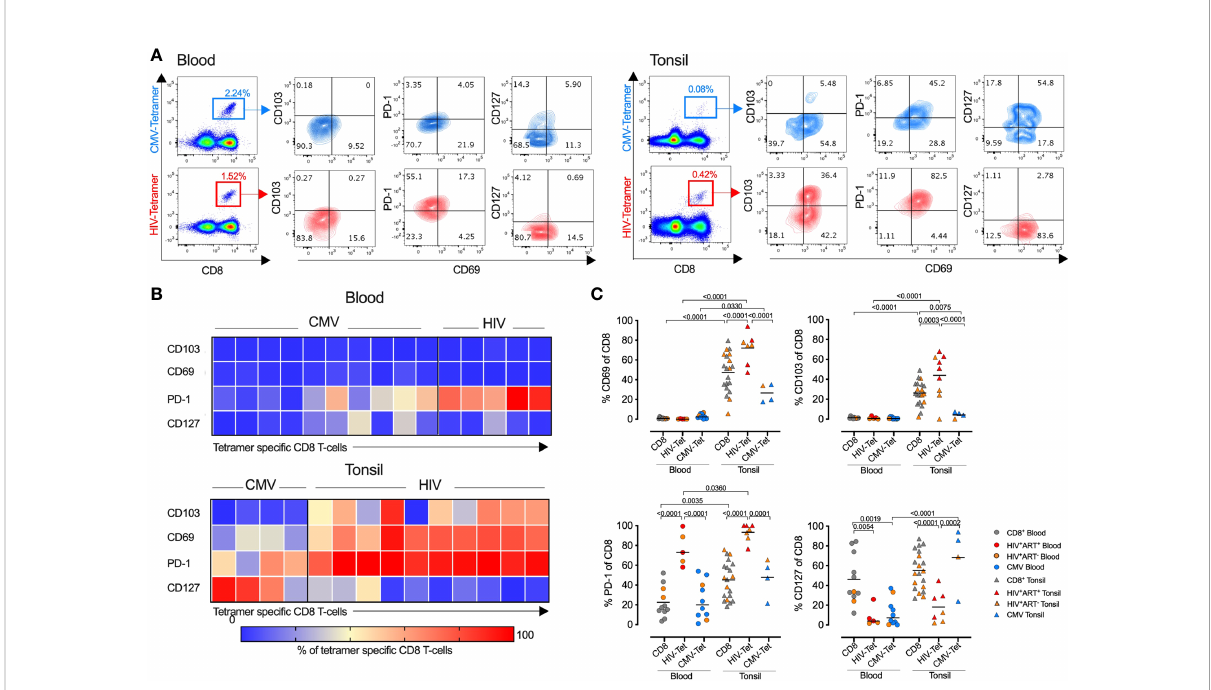
FIGURE 4 HIV speci fi c CD8 + T-cells express high levels of PD-1 and CD69 compared to CMV- and non-speci fi c CD8 + T-cells in tonsils. (A) Representative FACS plots showing CMV- (top) and HIV-speci fi c (bottom) tetramer stains of blood (left) and tonsil tissue (right) from the same HIV + individual with indicated markers listed. (B) Heatmap showing expression frequencies for the indicated markers among CD8 + T-cells from CMV tetramer and HIV tetramer speci fi c gated CD8 + T-cells in blood (top) and tonsil (bottom) with frequencies for each tetramer population indicated by the intensity bar below from blue (0%) to red (100%). (C) Frequencies of CD69, CD103, PD-1 and CD127 from HIV-, CMV-, and non-speci fi c ( ‘ CD8 ’ ) CD8 + T-cells within blood ( n= 11, left) and tonsil ( n= 20, right) matched tissue. P-values calculated using ordinary one-way ANOVA with horizontal bars representing median values with the level of signi fi cance indicated